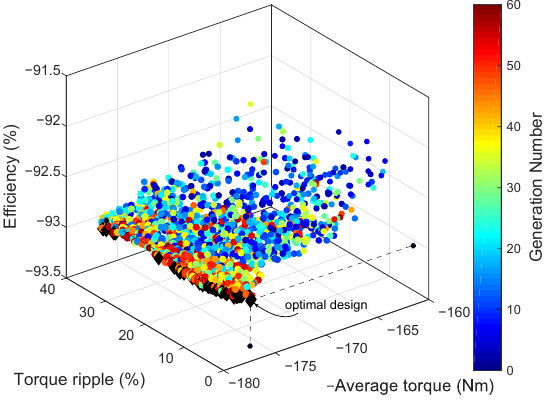
Figure 10. Optimization results of the 54s-6p SynRMs. Table 3. Rotor Parameter Values of the Optimal SynRM